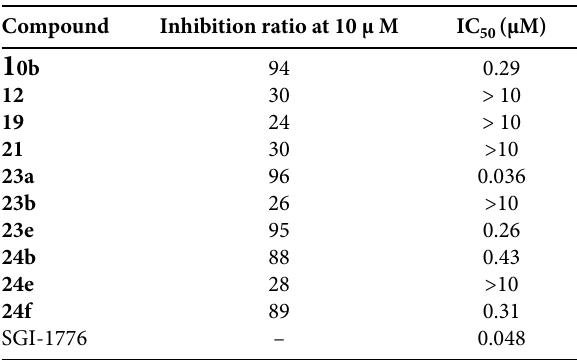
compounds showed strong inhibition against both c-Met kinase and the cancer cell lines tested. The most active compounds were 10b , 23a , 23e , 24b , and 24f , with IC 50 values of 0.29, 0.036, 0.26, 0.43, and 0.31 m M, respectively. Table 4 . The inhibitions of compounds 10b , 12 , 19 , 21 , 23a , 23b , 23e , 24b , 24e and 24f toward Pim-1 kinase.